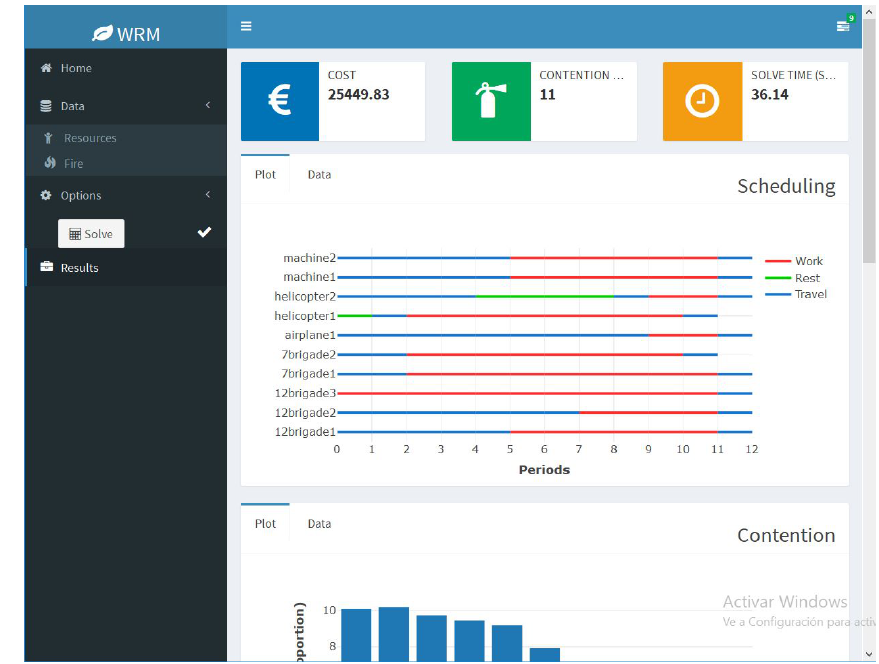
Figure 5. View of typical results for an instance run with the interface wrm package in software R